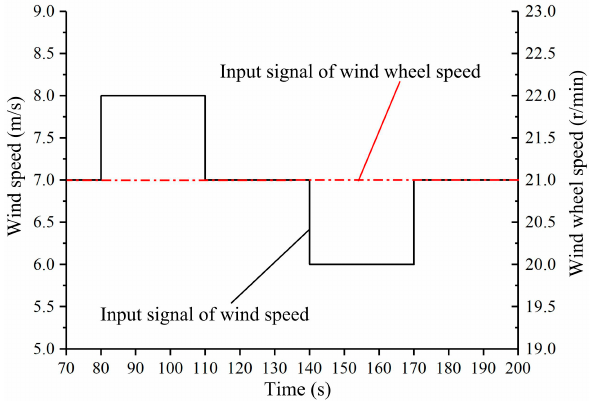
Figure 10. The first input step signal.